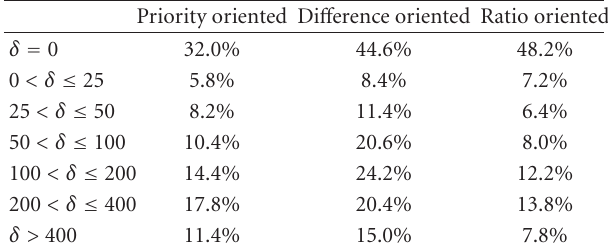
Table 3: Comparison of the requests scale-down for di ff erent scaling schemes.